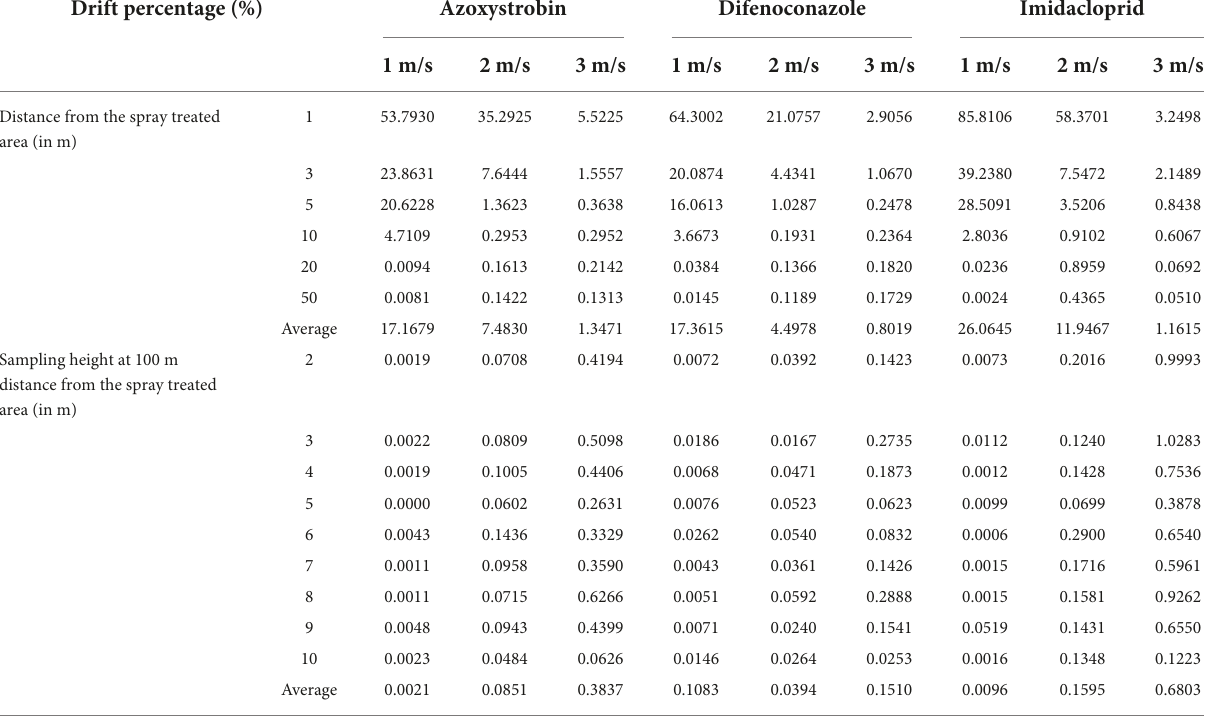
TABLE 4 Spray drift percentage (%) for the three pesticides used in the experiments under the setting flight velocity. Drift percentage